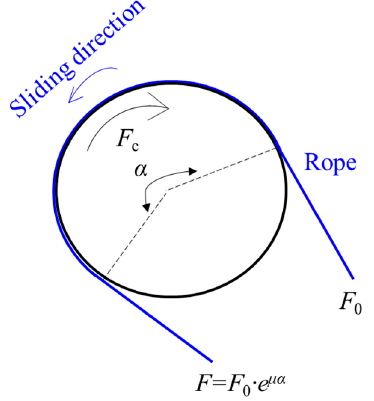
Figure 21. The Capstan friction model [9].